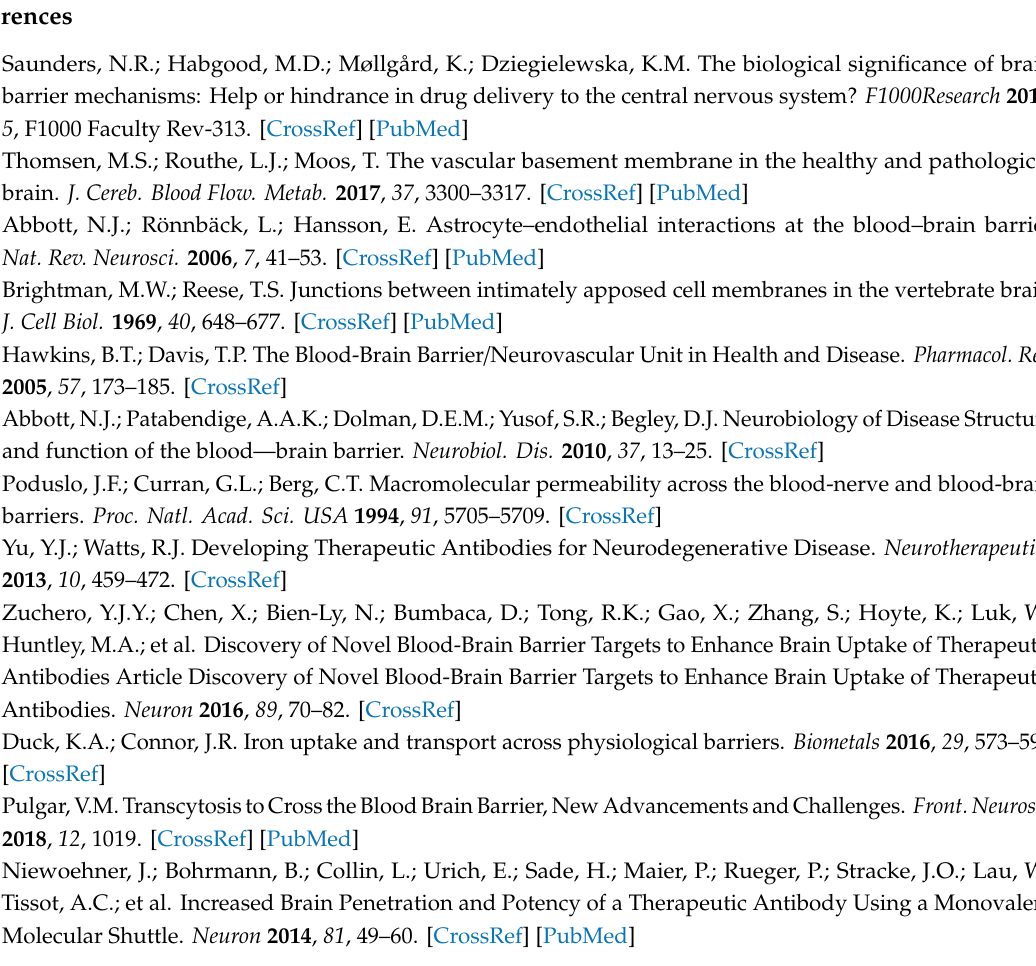
Figure S1: Non-cropped SDS-PAGE analysis of purified proteins, Figure S2: SDS-PAGE analysis of reduced- and non-reduced recombinant proteins, Figure S3: Representative plot from flow-cytometric analysis with gating indicated, Table S1: Serum and CSF concentrations, and C CSF / C serum ratios of the two investigated proteins in individual